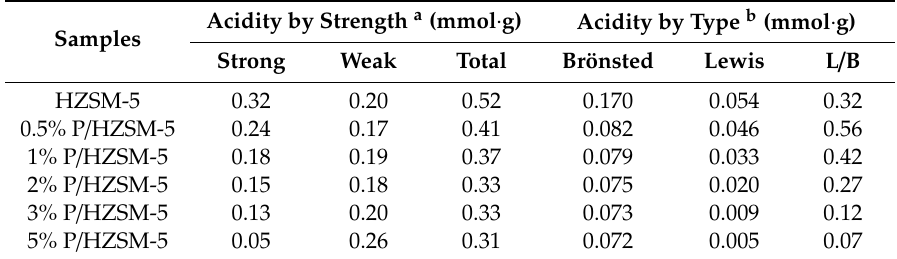
c ( B ) Figure 6. 27 Al MAS NMR spectra ( A ) and 31 P MAS NMR spectra ( B ) of parent and P-modified HZSM- 5 zeolites: ( a ) HZSM-5, ( b ) 0.5% P/HZSM-5, ( c ) 1% P/HZSM-5, ( d ) 2% P/HZSM-5, ( e ) 3% P/HZSM-5 and ( f ) 5% P/HZSM-5.